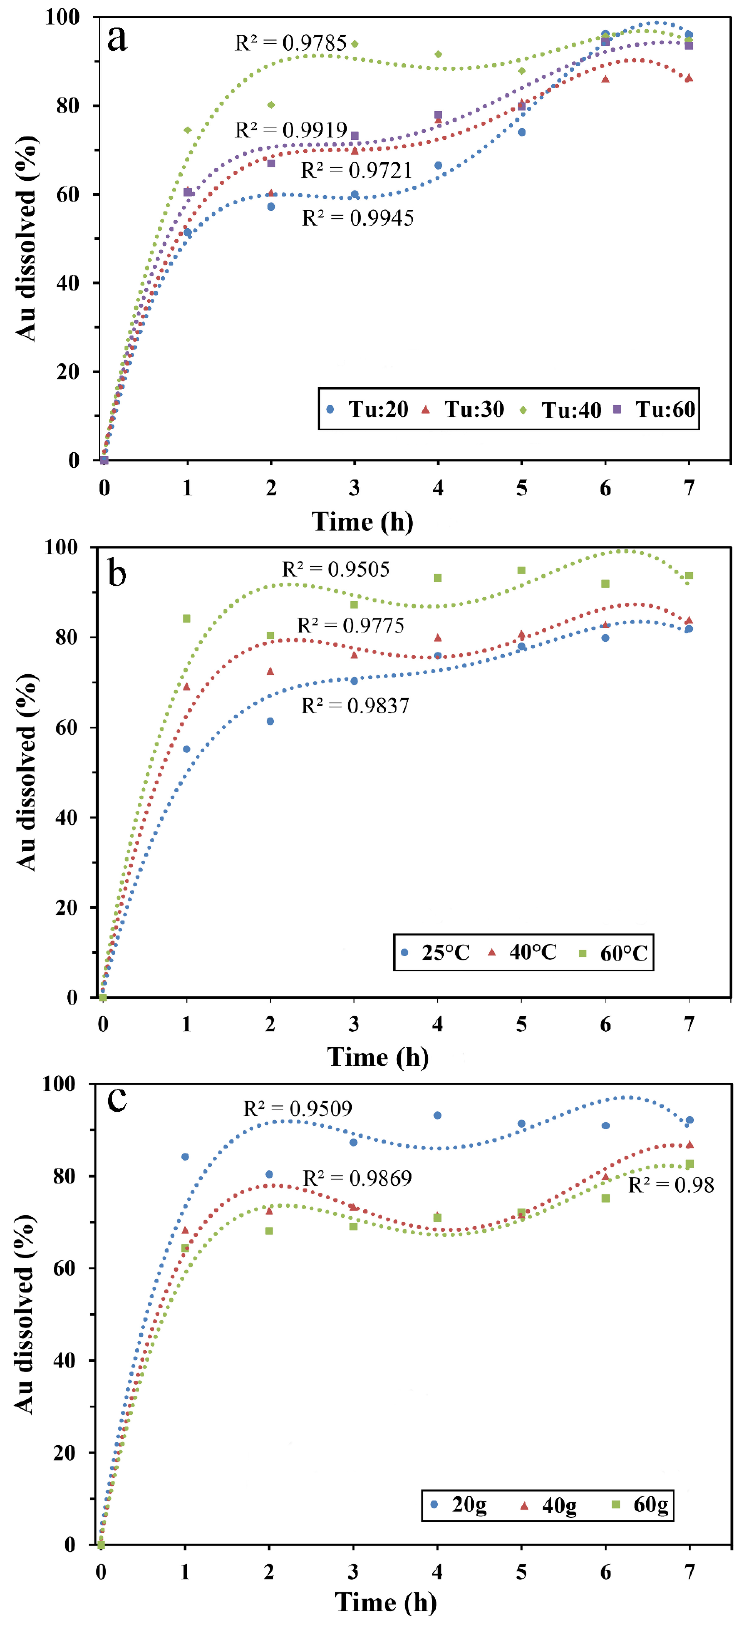
Figure 8. The effect of ( a ) thiourea concentration, ( b ) temperature and ( c ) pulp density on Au dissolution. (Experiment condition 0.5 M H 2 O 2 , pH: 1).